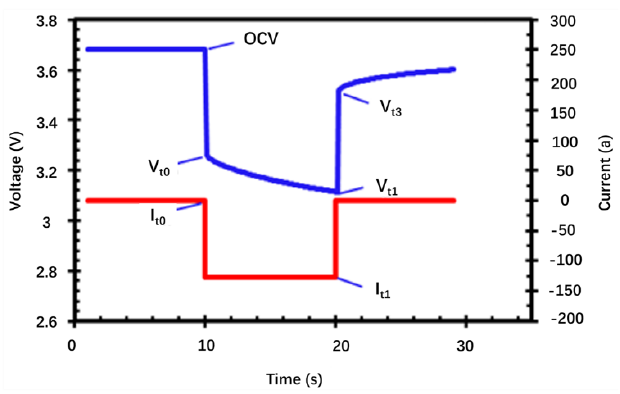
Figure 3. Pulse − power characterization profile.